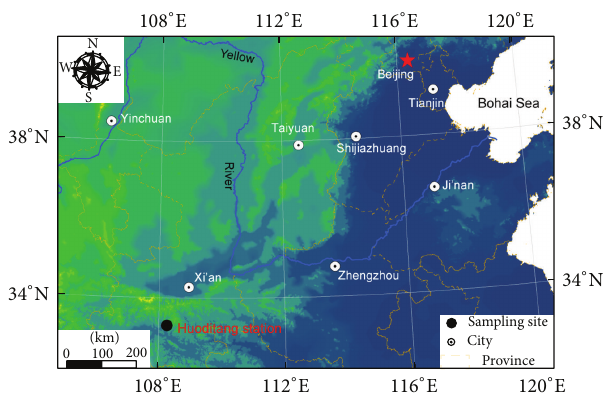
Figure 1: Location of the Huoditang area at Qinling Mountains in Ningshan county of Shaanxi